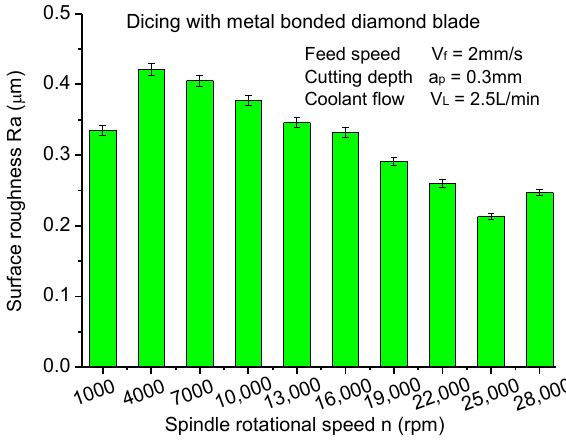
Figure 6. Surface roughness varying with spindle rotational speed.